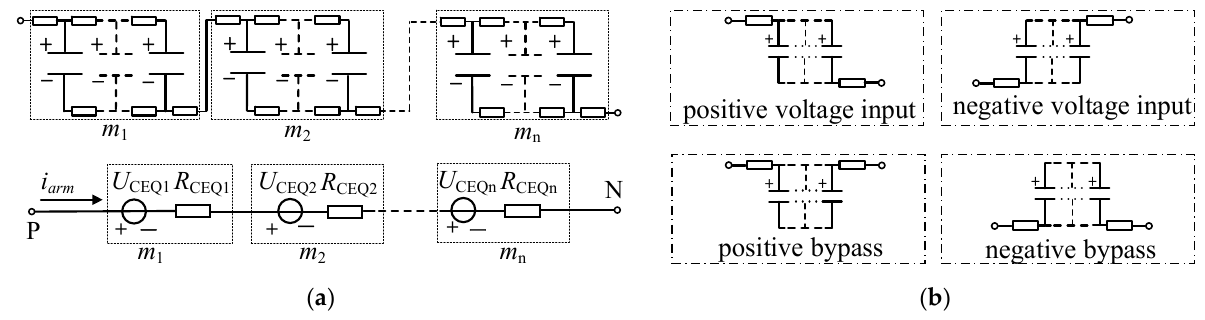
Figure 7. Submodule segment in PFBSM–MMC bridge arm: ( a ) segmented structure and equivalent